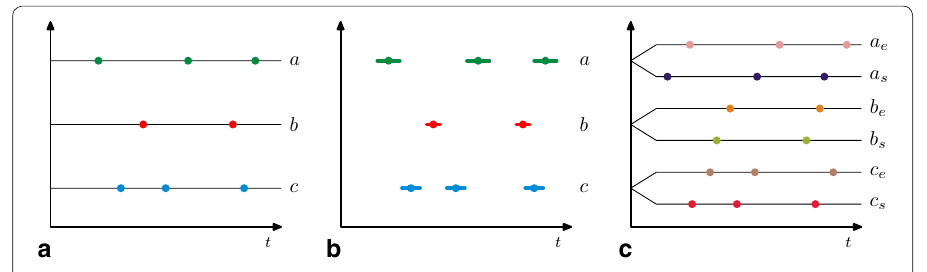
Fig. 7 Conversion of time interval events to a set of pointwise events based on beginning/end points a Time points of the events a , b and c , b Including uncertainty, c Starting and ending times of uncertainty intervals for the events a , b and